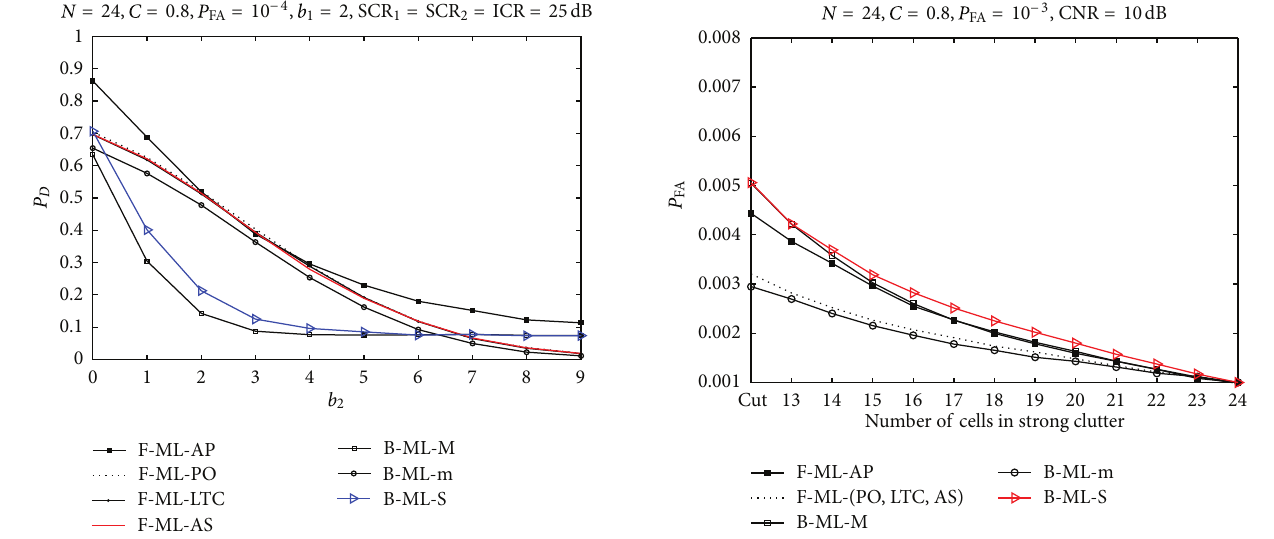
of interfering target at sensor 2 𝑏𝑏